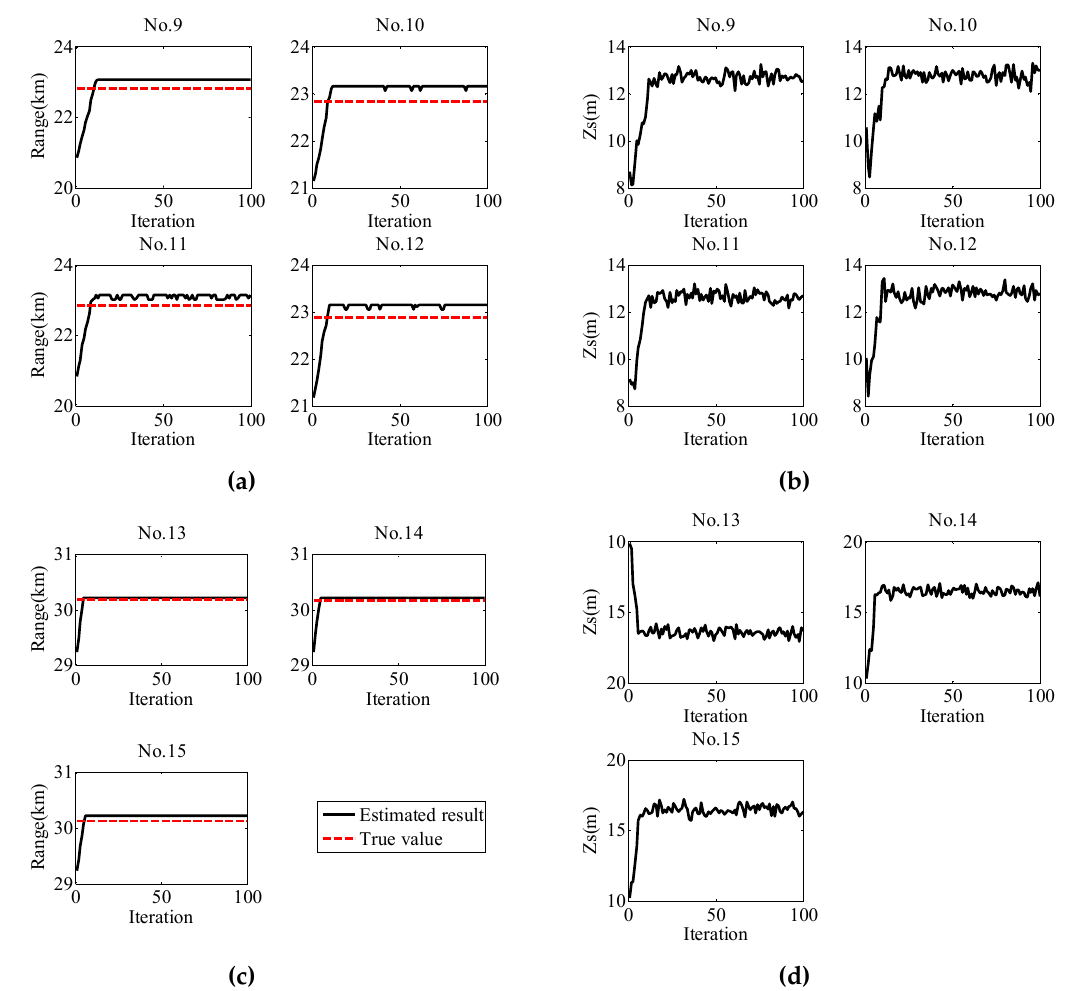
Figure 12. PF positioning results for the No.9–No.15 explosions. ( a ) Range estimation results for the No.9–No.12 explosions; the estimated results and the global positioning system (GPS) ranges are represented by the black line and red dotted line, respectively; ( b ) source depth estimation results for the No.9–No.12 explosions; ( c ) range estimation results for the No.13–No.15 explosions; the estimated results and the GPS ranges are represented by the black line and red dotted line, respectively; ( d ) source depth estimation results for the No.13–No.15 explosions. Table 7. Distances of the explosives from the first array and the MAPEs of the localization results. No. MAPE (%) for range MAPE (%) for source